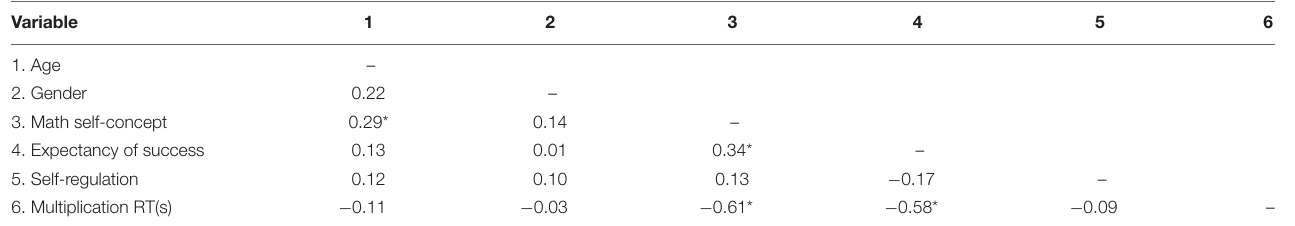
TABLE C2 | Correlations between background variables, self-regulation, and multiplication RT in Iranian students.